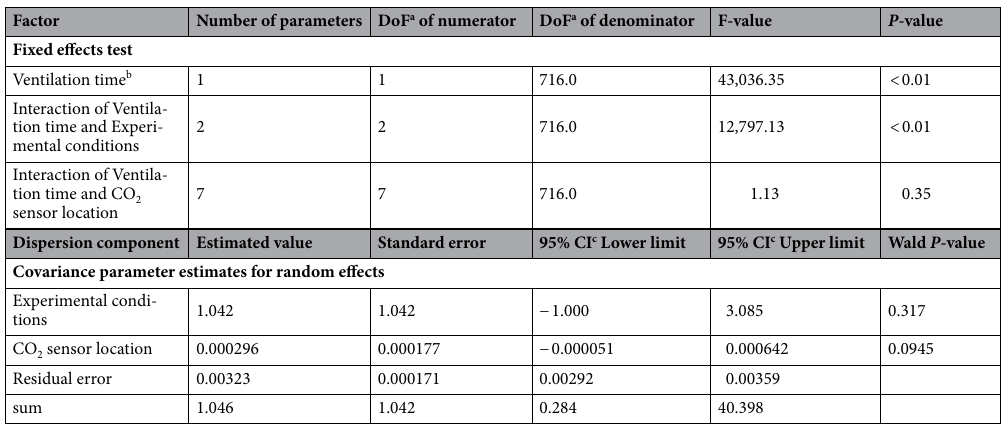
Table 3. Effects of experimental conditions and CO 2 sensor location by mixed-effect model. a DoF: Degrees of freedom. b ventilation time means elapsed time from ventilation initiation. c CI: confidence